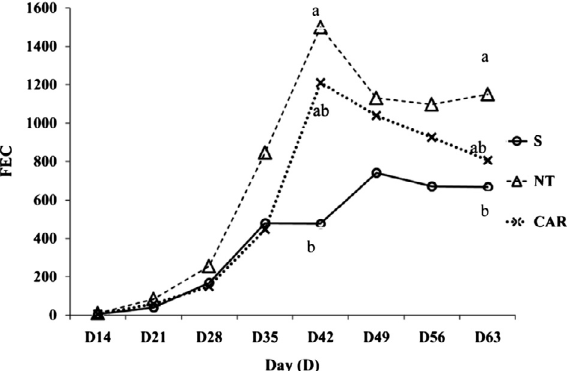
Figure 2. Faecal egg counts (arithmetic mean of eggs per gram of faeces) based on the different diet regimes over the study period (D14–D63). S (sainfoin), NT (non-treated/positive control), CAR